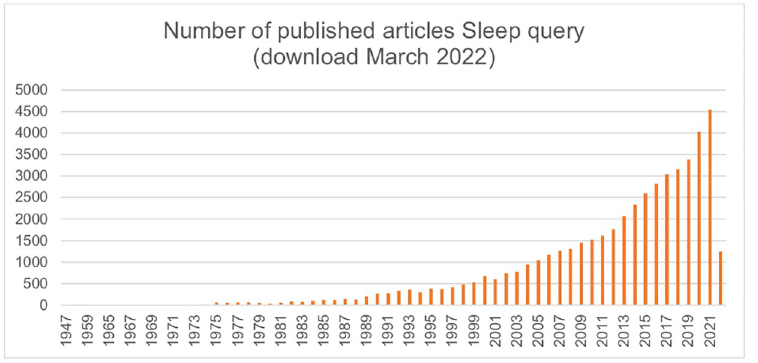
Fig 2. Published articles in PubMed on